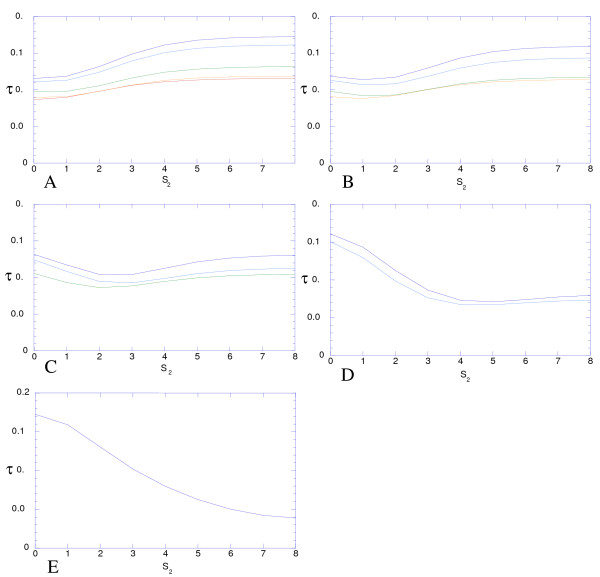
Half-approach period τ = ln 2/r, in the units of the mutation rate, in the case of four alleles, under different modes of selection. S3 = 0, 1, 2, 4, and 8 (A - E). S4 = 0, 1, 2, 4, and 8 (red, orange, green, light blue, deep blue).